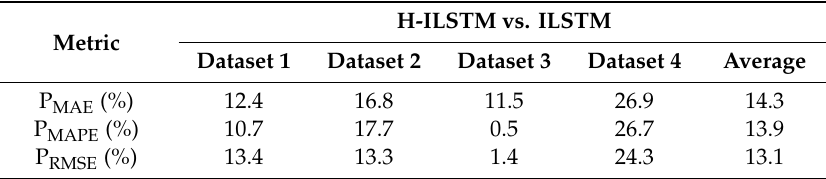
Table 10. The promoting percentages of the ILSTM model by the H-ILSTM model of two-step prediction for the load datasets 1–4.